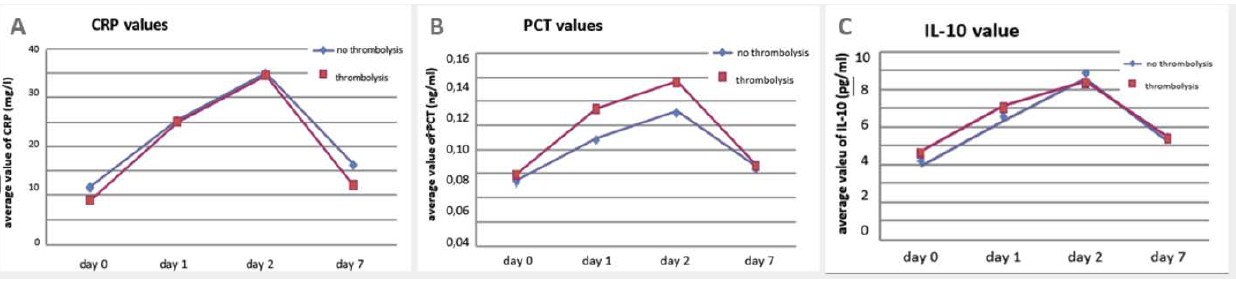
Figure 1. Dynamics of inflammatory factors expression in both groups measured at the admission, 24 hours, 48 hours and seven days after admission. All measured inflammatory markers, CRP (A), PCT (B) and IL-10 (C) showed similar pattern; intensive growth in first and second day, decreased values at day seven, but still slightly higher than at the admission. No statistically significant difference was observed in between